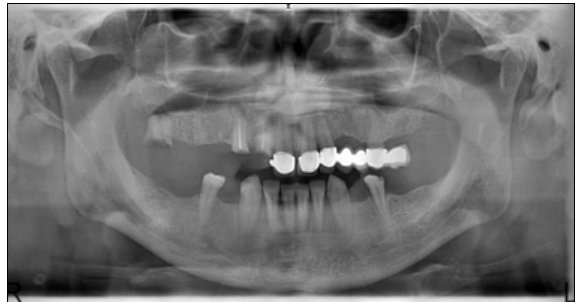
Figure 3. Panoramic radiograph of a 24-year-old patient who complained of pain due to a canine that transmigrated from left to right quadrant.